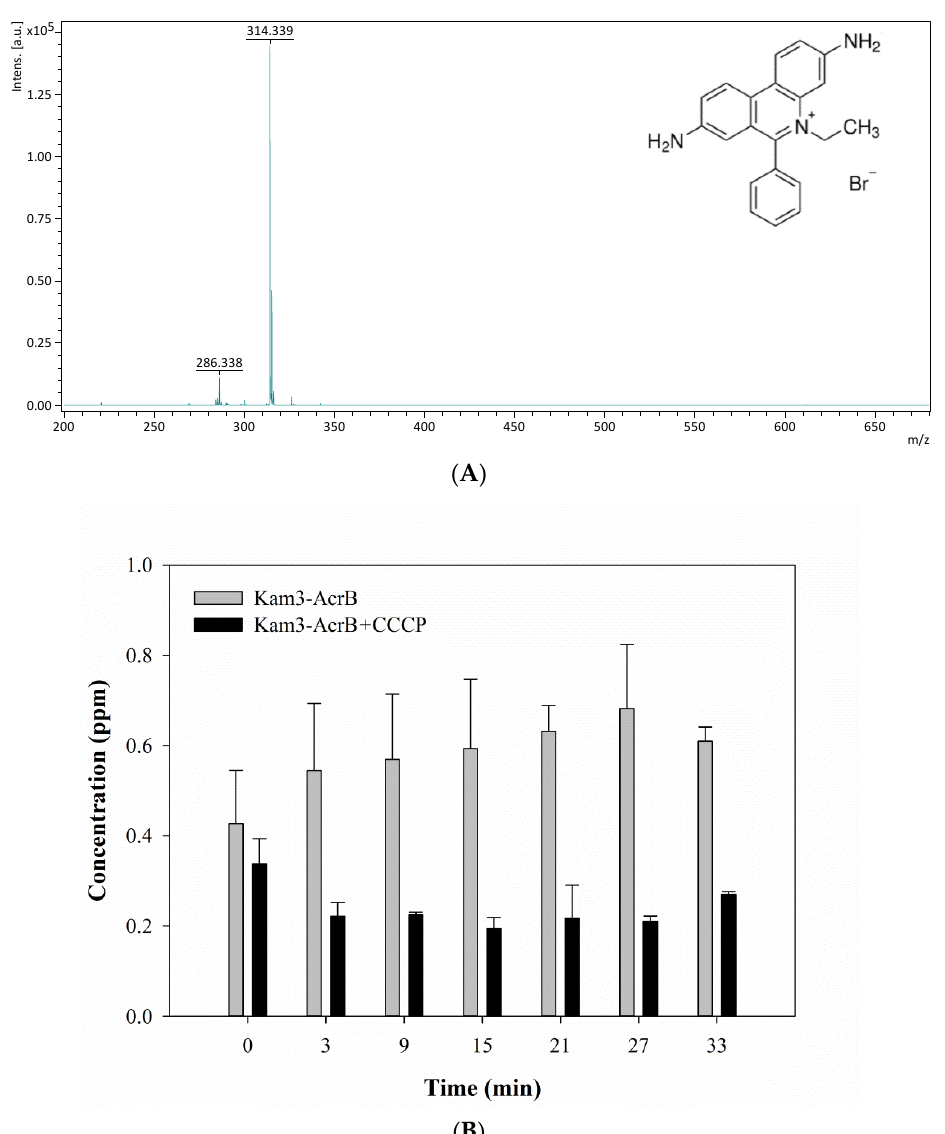
Figure 5. The ethidium bromide efflux activity of Kam3-AcrB was detected by using MALDI-TOF MS in the presence of modulator CCCP. ( A ) The mass spectrum of EtBr and ( B ) the intensity of extracellular EtBr. The intensity was plotted at the main peak at m / z 314.34 of EtBr and the detection period was 33 min. Values are expressed as mean ± standard deviation (SD) ( n = 3).